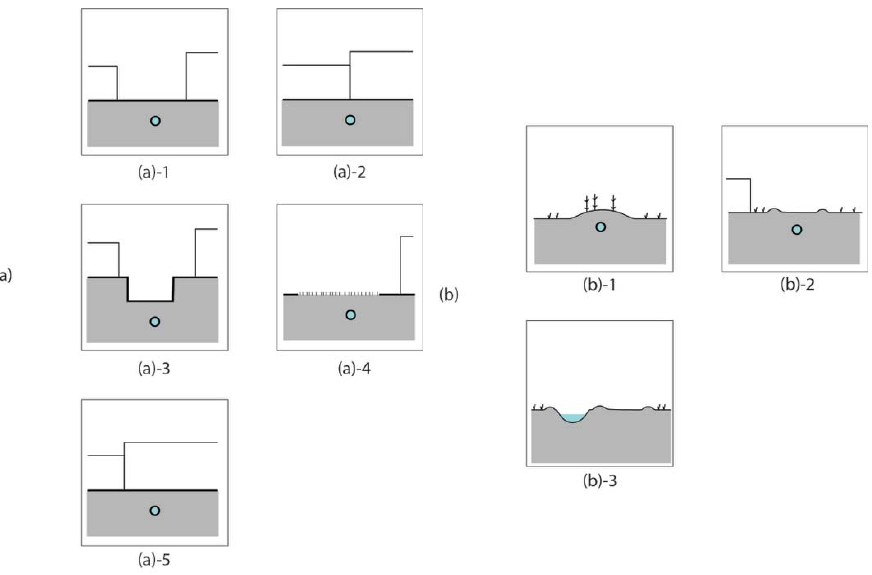
Figure 21. Typologies of the relationship between buried irrigation canal and current urban landform. Group ( a ) shows the section patterns in urbanized areas. ( a )-1: The irrigation layout corresponds to the road layout. ( a )-2: The irrigation layout corresponds to the plot inner separations. ( a )-3: Sunken topography created with canals and current urban landform. ( a )-4: Urban green transformed from floodplain of canals ( a )-5: Current urban landform that is not related to the irrigation canal. Group ( b ) shows the section patterns in rural areas. ( b )-1: The irrigation canal layout corresponds to the ridge of the earth between crops. ( b )-2: The irrigation canal layout corresponds to the rural road layout. ( b )-3: The irrigation canal that is currently used corresponds to the road layout.